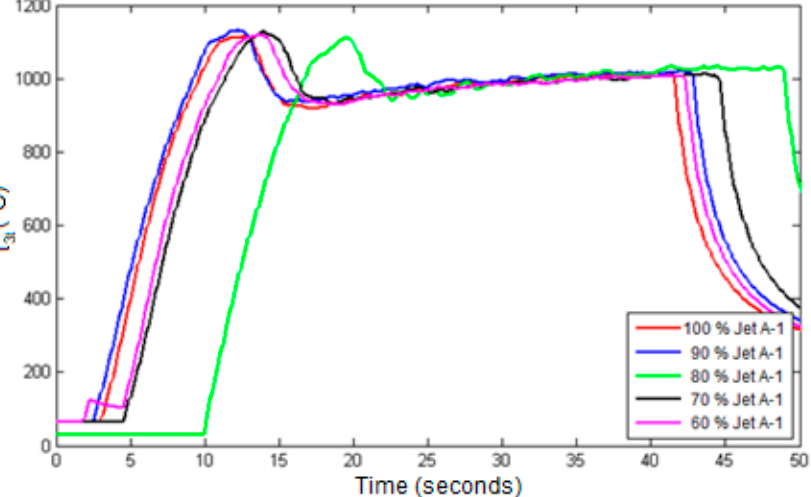
Figure 12. The graphical course of the change in the total gas temperature in front of the gas turbine